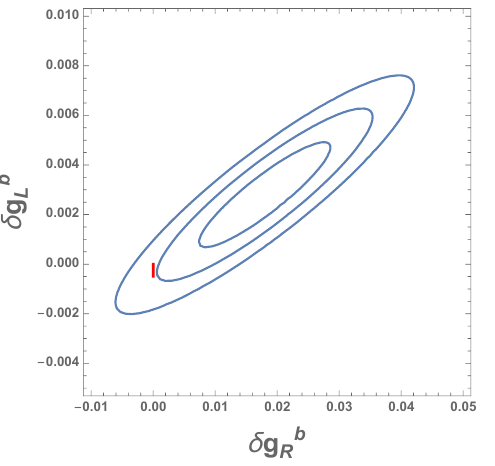
; (cid:14)g b ) plane. The R L